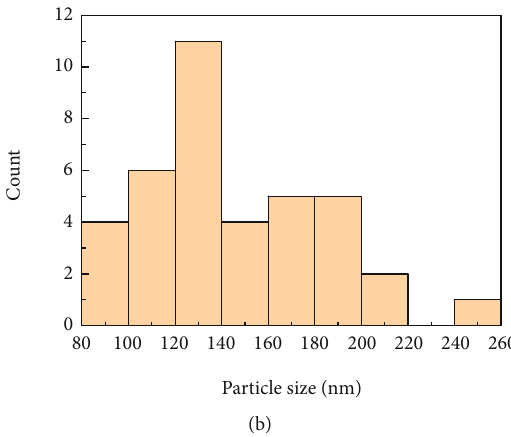
Figure 9: Scanning electron microscope images of (a) Amlop-polymer nanocomposite and (b) the histogram data for Amlop-polymer nanocomposite.